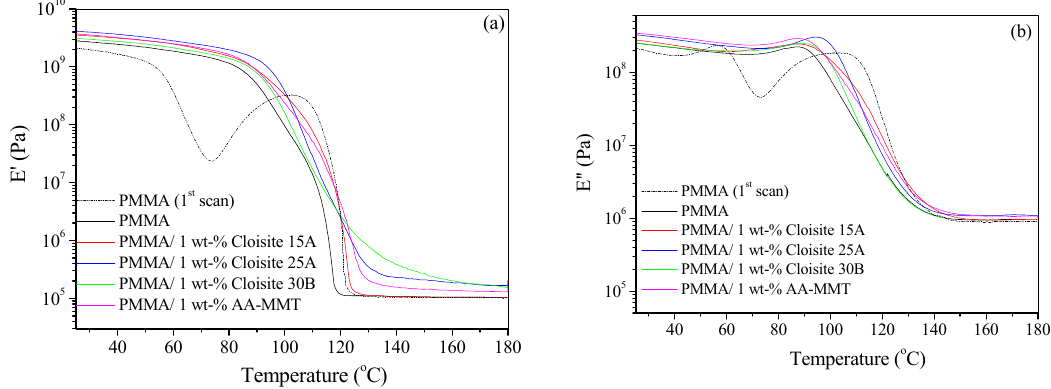
Figure 8. Storage modulus E ′ ( a ), and loss modulus E ″ ; ( b ) as a function of temperature of PMMA nanocomposites containing different OMMT types.